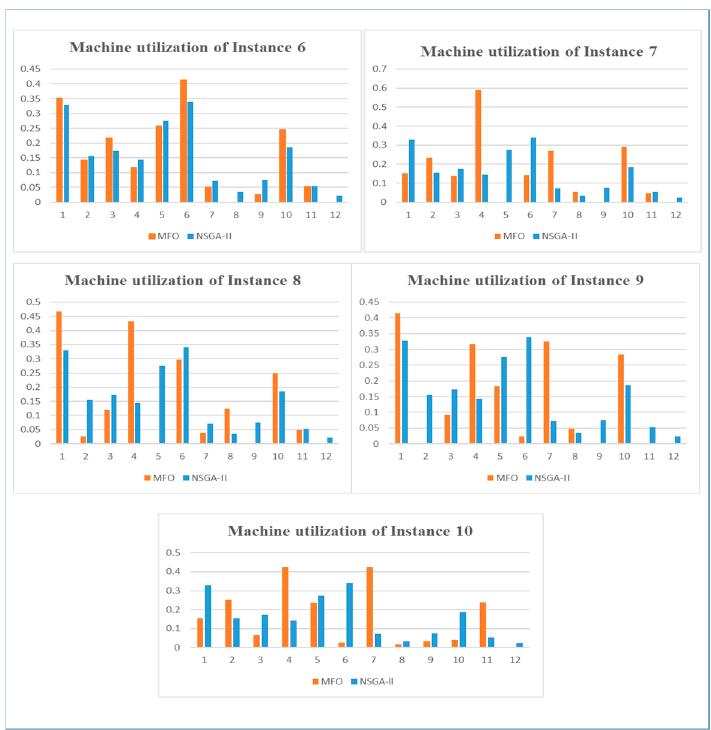
Figure 13. Utilization rate of different machines of instance 6–10.